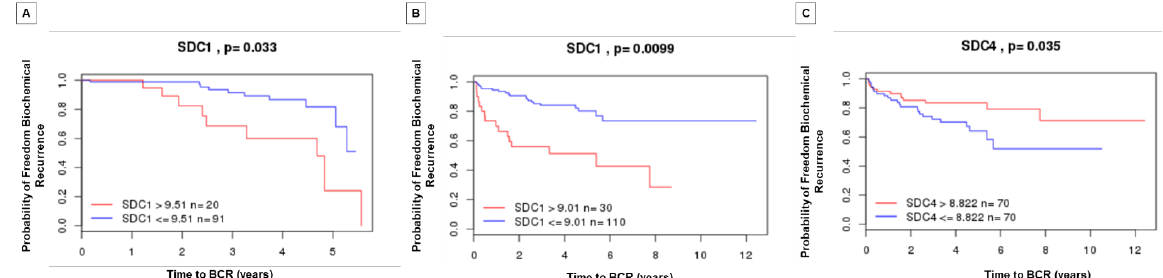
Figure 6. Kaplan–Meier curves displaying the probability of freedom from biochemical recurrence of PCa with ( red ) or without ( blue ) SDC1 and SDC4 overexpression. Analyzed by the Cambridge Carcinoma of the Prostate App (camcAPP dataset) [37] from an integrative study. ( A ) Kaplan–Meier curve with the probability of freedom from biochemical recurrence of PCa with ( red ) or without ( blue ) SDC1 overexpression from the Cambridge study [38]. The difference is statistically significant, p = 0.033. ( B ) Kaplan–Meier curve with the probability of freedom from biochemical recurrence of PCa with ( red ) or without ( blue ). SDC1 overexpression from the Memorial Sloan-Kettering Cancer Center (MSKCC) study [39]. The difference is statistically significant, p = 0.0099. ( C ) Kaplan–Meier curve with the probability of freedom from biochemical recurrence of PCa with ( red ) or without ( blue ) SDC4 overexpression from the MSKCC study [39]. The difference is statistically significant, p =